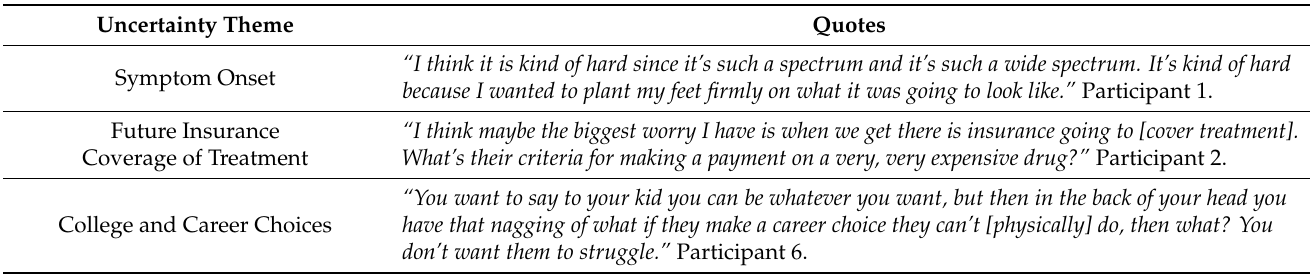
Table 5. Uncertainties related to participants having a child living with an LOPD diagnosis.